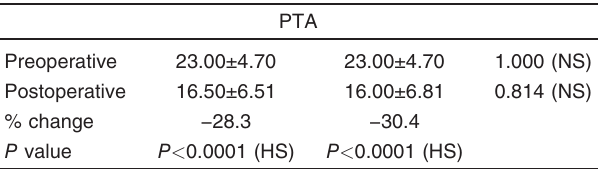
Table 4 Difference in pure tone audiometry before and after intervention in both study